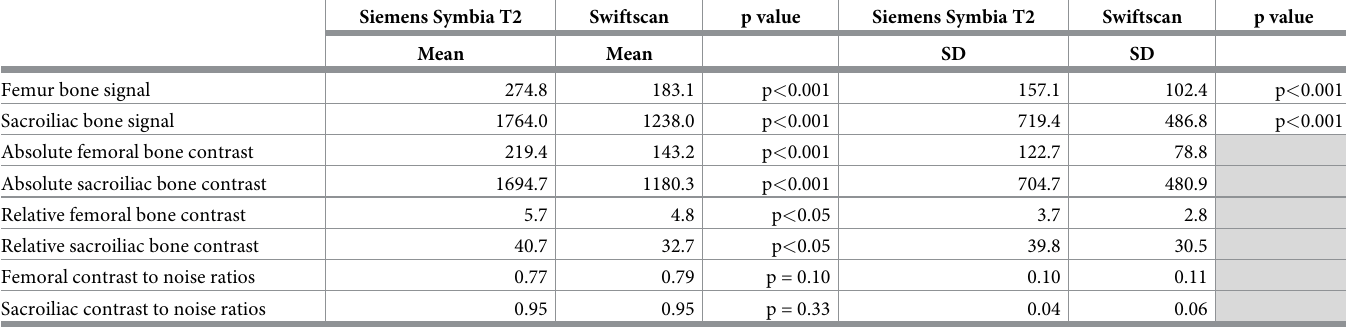
Table 3. Signal, noise and contrast